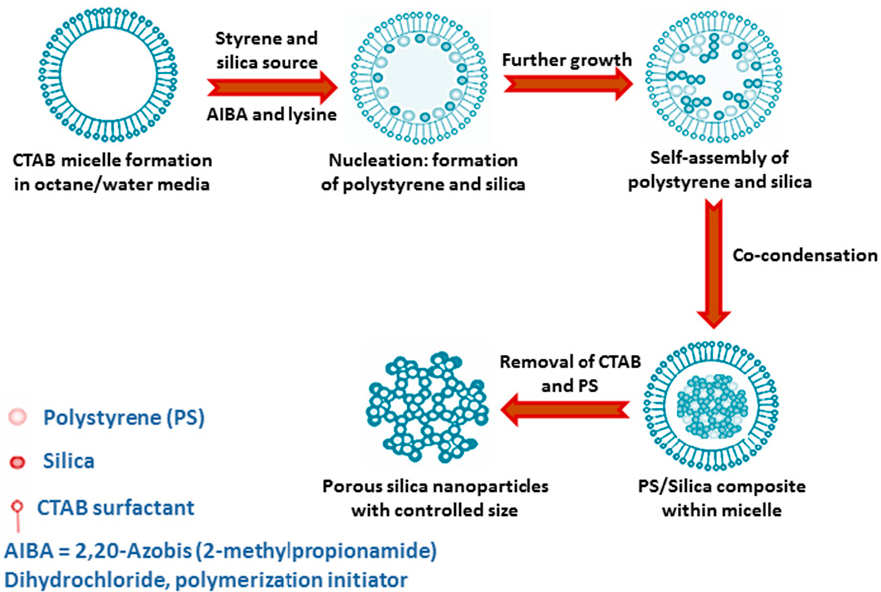
Figure 3. A schematic representation for mesoporous silica nanoparticles formation in presence of Cetyltrimethylammonium bromide-Polystyrene (CTAB-PS) and amino acid